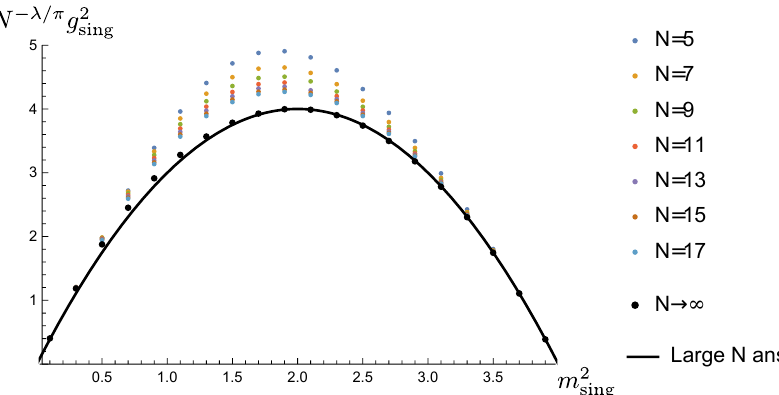
Figure 12 . Comparison between the numerics discussed in section 3.2 and large N analysis for the case with a single pole in the singlet representation. The maximum couplings are rescaled according to the power of N in (4.13). The (cid:12)nite N results in (cid:12)gure 8 (coloured points) are extrapolated to in(cid:12)nity (black points) and matched against the large N ansatz (solid